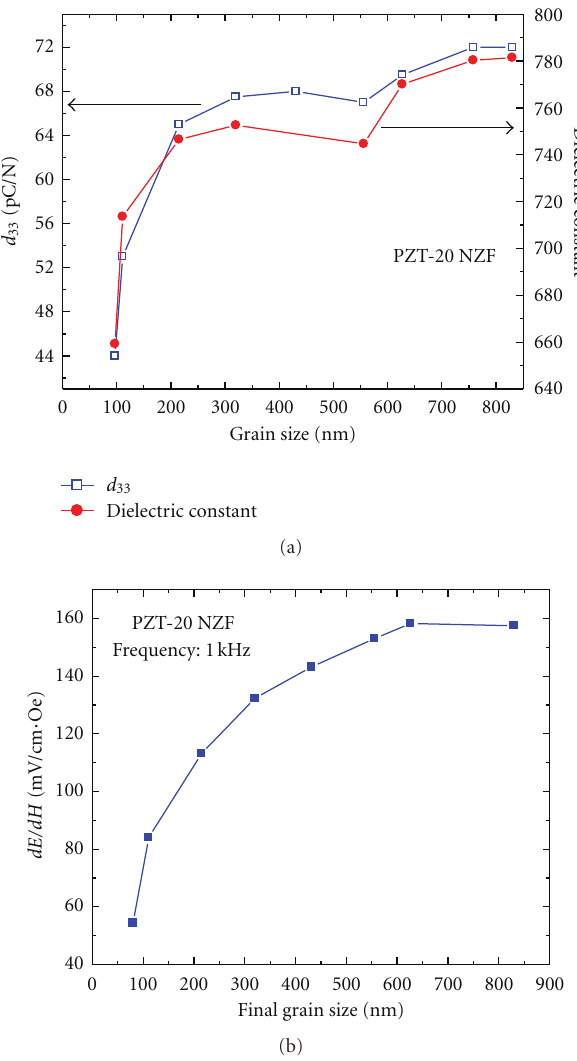
Figure 8: E ff ect of ferroelectric grain size on the piezoelectric, dielectric and magnetoelectric property of PZT-20 NZF composite.